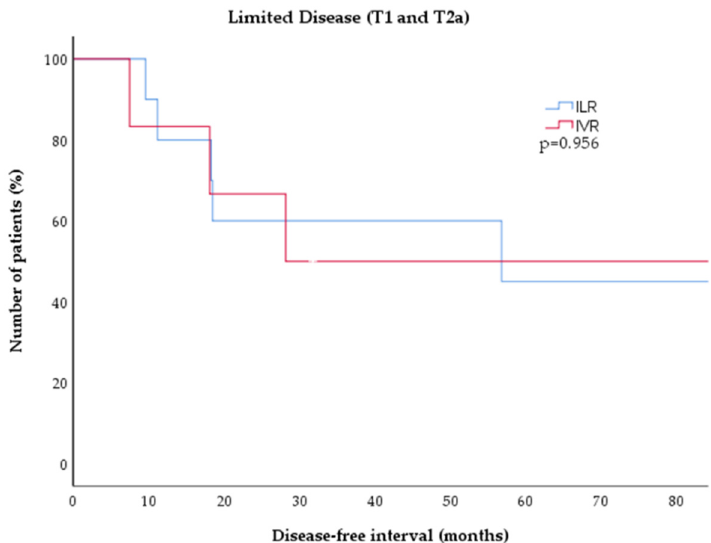
Figure 3. Kaplan–Meier estimates of disease ‐ free survival in low ‐ grade CBCL (T1 and T2 disease) after treatment with either ILR (blue) or IVR (red). There was no significant difference between tboth treatment cohorts ( p = 0.826). CBCL = cutaneous B ‐ cell lymphoma; ILR = intralesional rituximab; IVR = intravenous rituximab.